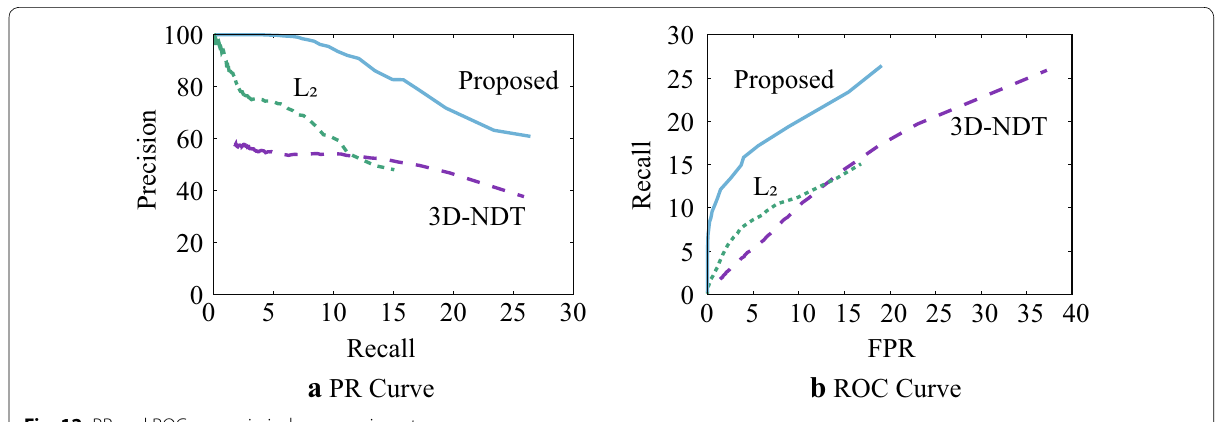
Fig. 12 PR and ROC curves in indoor experiment